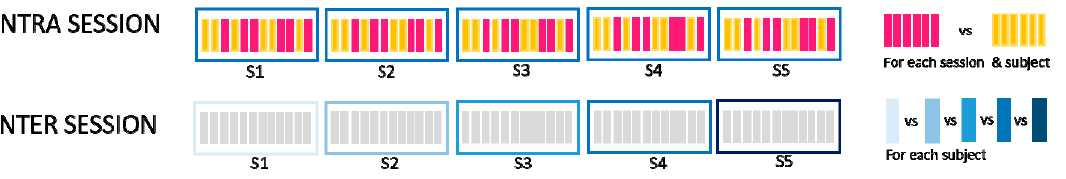
Figure 5. Two data groups were identified to perform analysis of muscle synergy stability. The intra-session dataset grouped synergies were extracted from 5 subsets of 6 repetitions of movements that was repeated for each session and subject. Here, for simplification, only 2 subsets are shown. The inter-session dataset grouped all 12 movement repetitions within each session to extract synergies representing a session. Five synergy sets (of 5 sessions) for each subject were